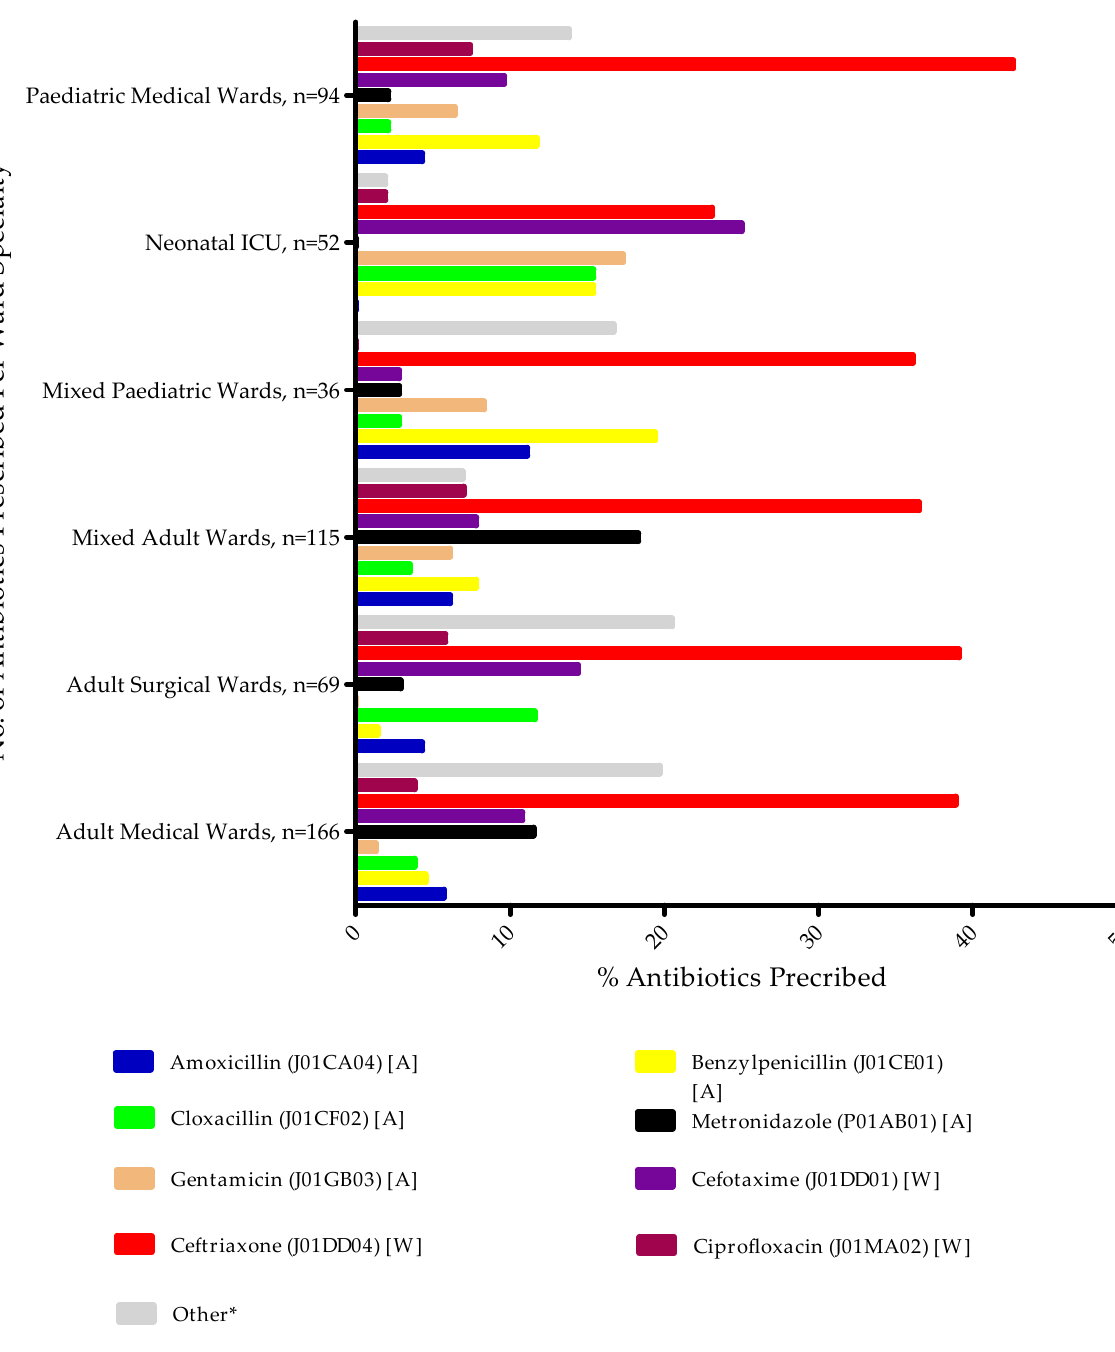
Figure 2. Commonly prescribed antibiotics at the ward level among participating hospitals. Key: * Other antibiotics prescribed include ampicillin, azithromycin, co-trimoxazole, erythromycin, meropenem, nitrofurantoin, and penicillin-V; [A]: Access; [W]: Watch. Patients could be prescribed more than one antibiotic.